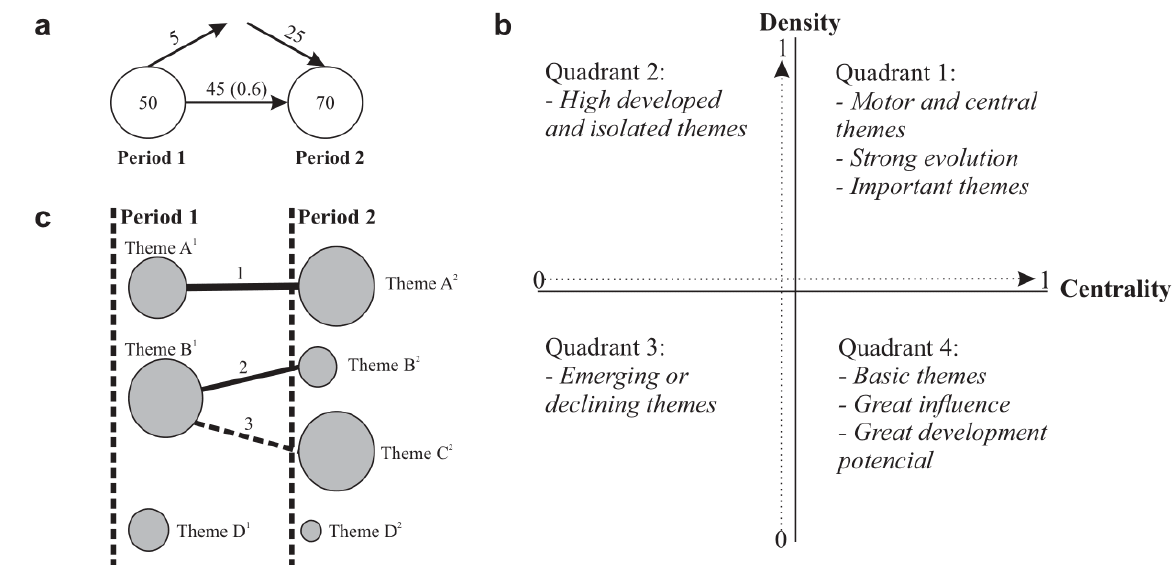
Figure 1. Schemes of the three science mapping tools generated by the SciMAT software. (a) The overlapping map, (b) The strategic diagram, (c) Thematic